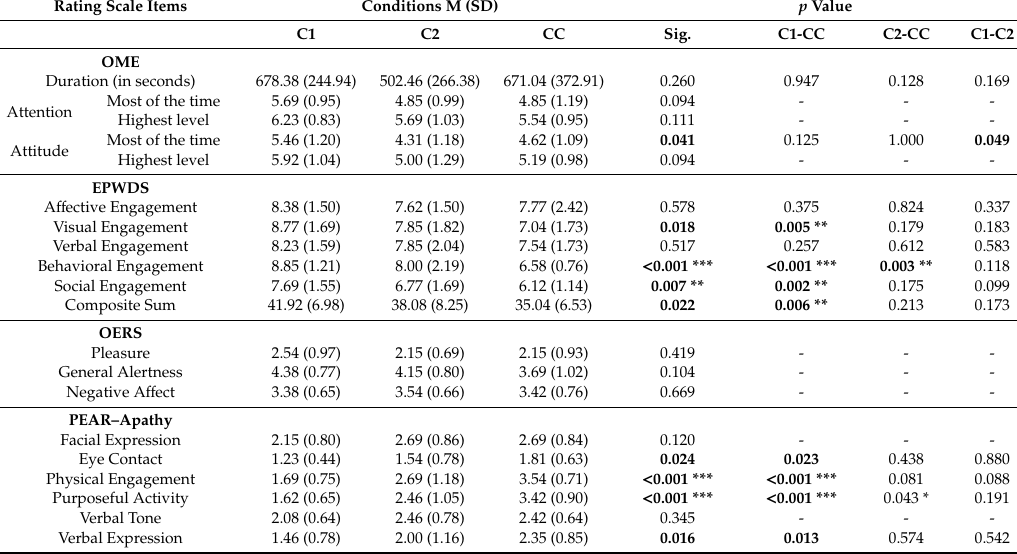
Table A2. Kruskal–Wallis H tests with pairwise comparisons and ANOVA tests with post hoc examinations performed on all rating items of four observational rating scales to disclose the di ff erences in engagement, a ff ect, and apathy among experiment conditions: C1, C2, and